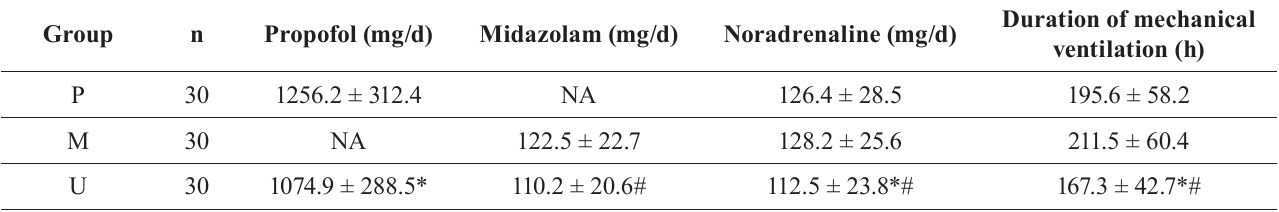
TABLE II - Comparison of sedative doses, vasoactive drug doses, and duration of mechanical ventilation